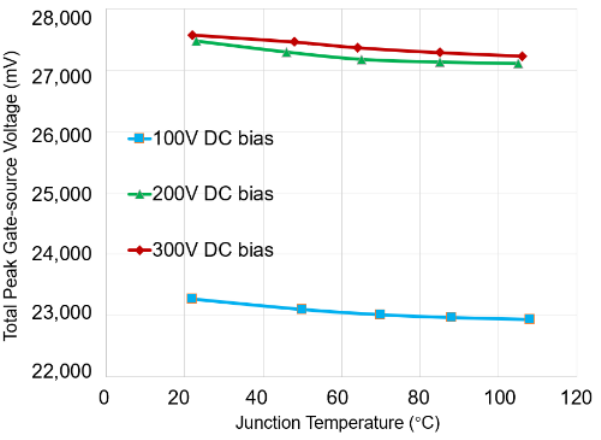
Figure 13. 𝑉 𝐺𝑆,𝑡𝑜𝑡𝑎𝑙 as a function of 𝑇 𝑗 and DC-link voltage in a fully operating DC/DC converter. Figure 13. V GS , total as a function of T j and DC-link voltage in a fully operating DC/DC